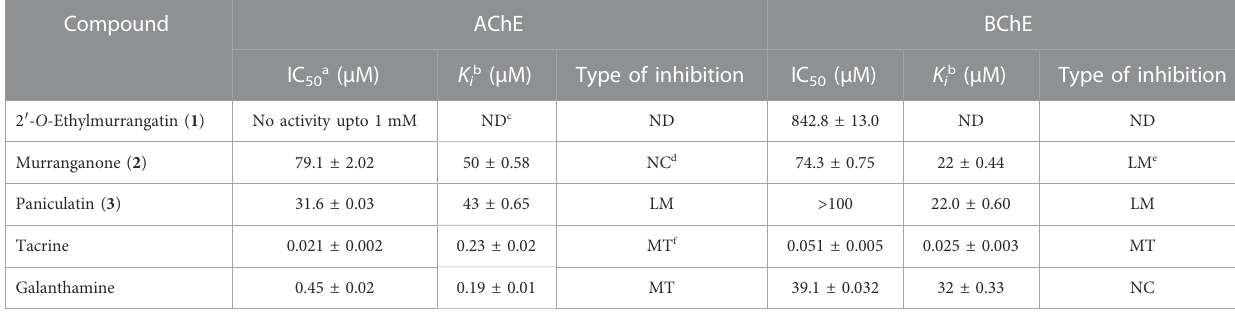
TABLE 1 The kinetics data for cholinesterase enzyme inhibition by the tested coumarins (1 – 3 ). Compound AChE